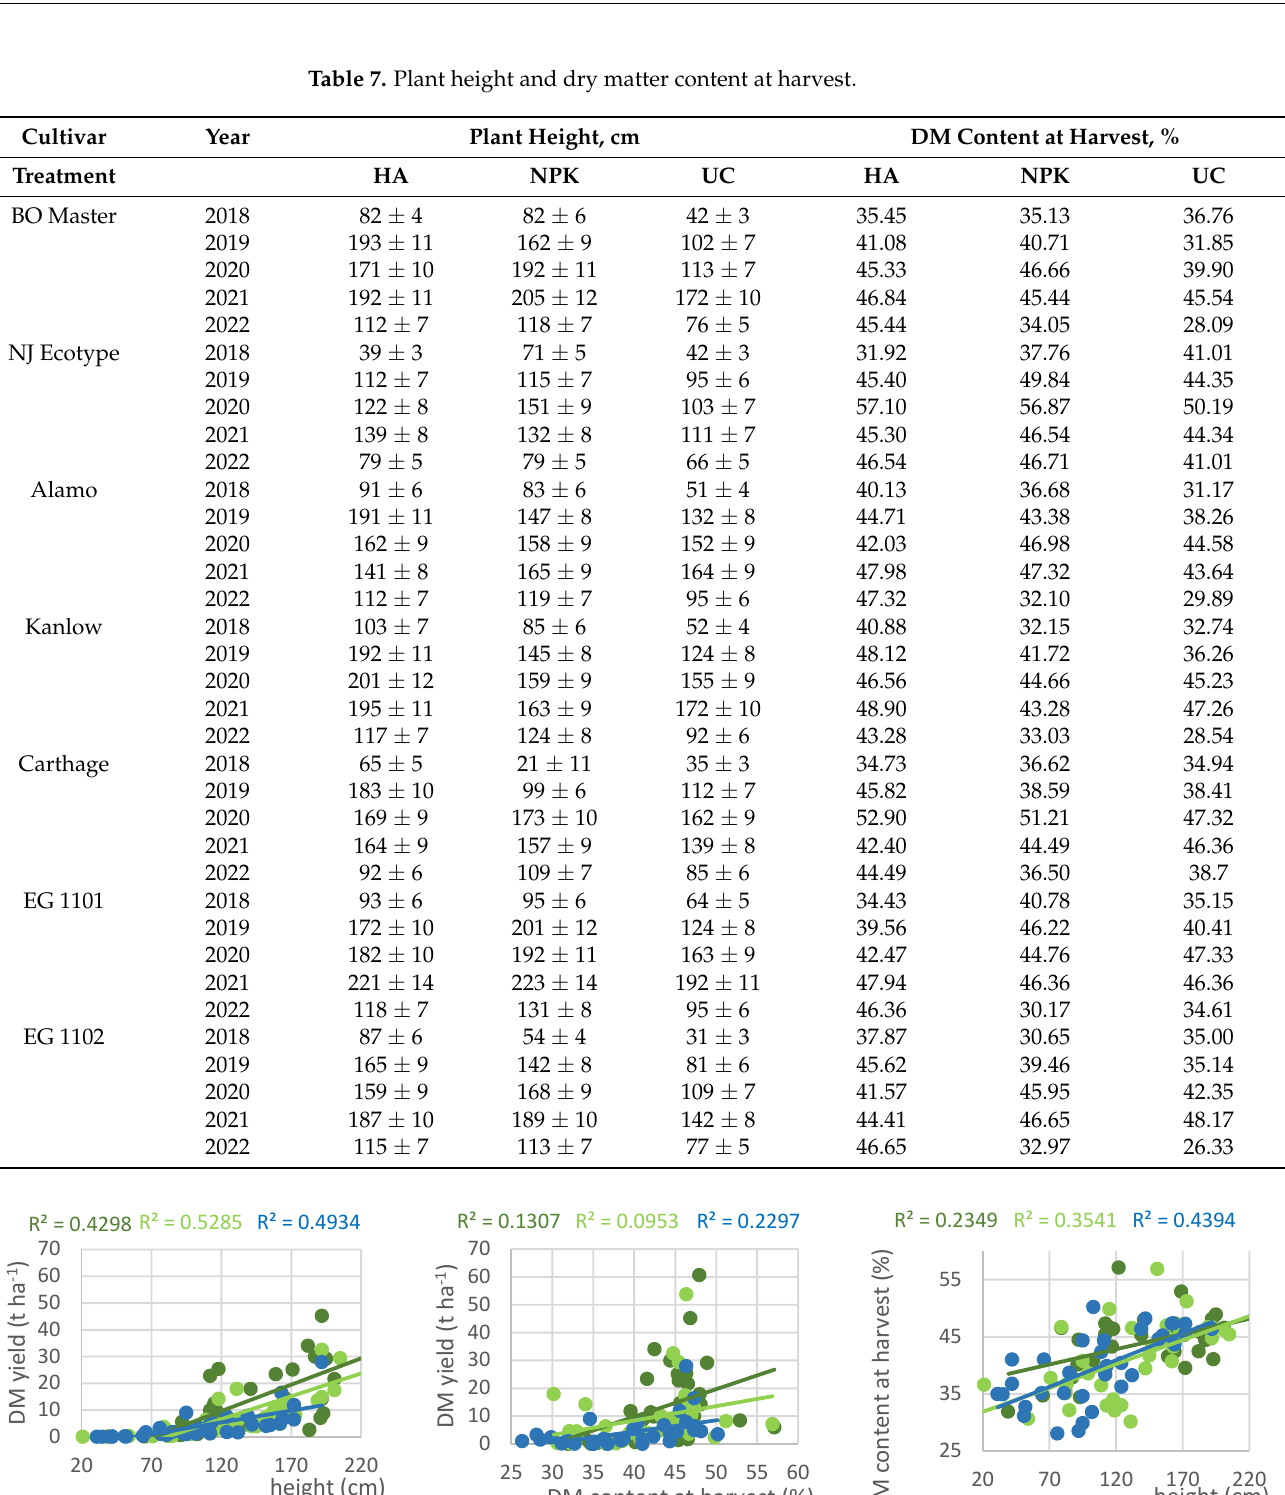
Figure 4. The linear course of dependence of dry matter yield on crop height ( a ), dry matter yield on dry matter content ( b ), and dry matter content on crop height ( c ) according to treatments HA, NPK, and UC.